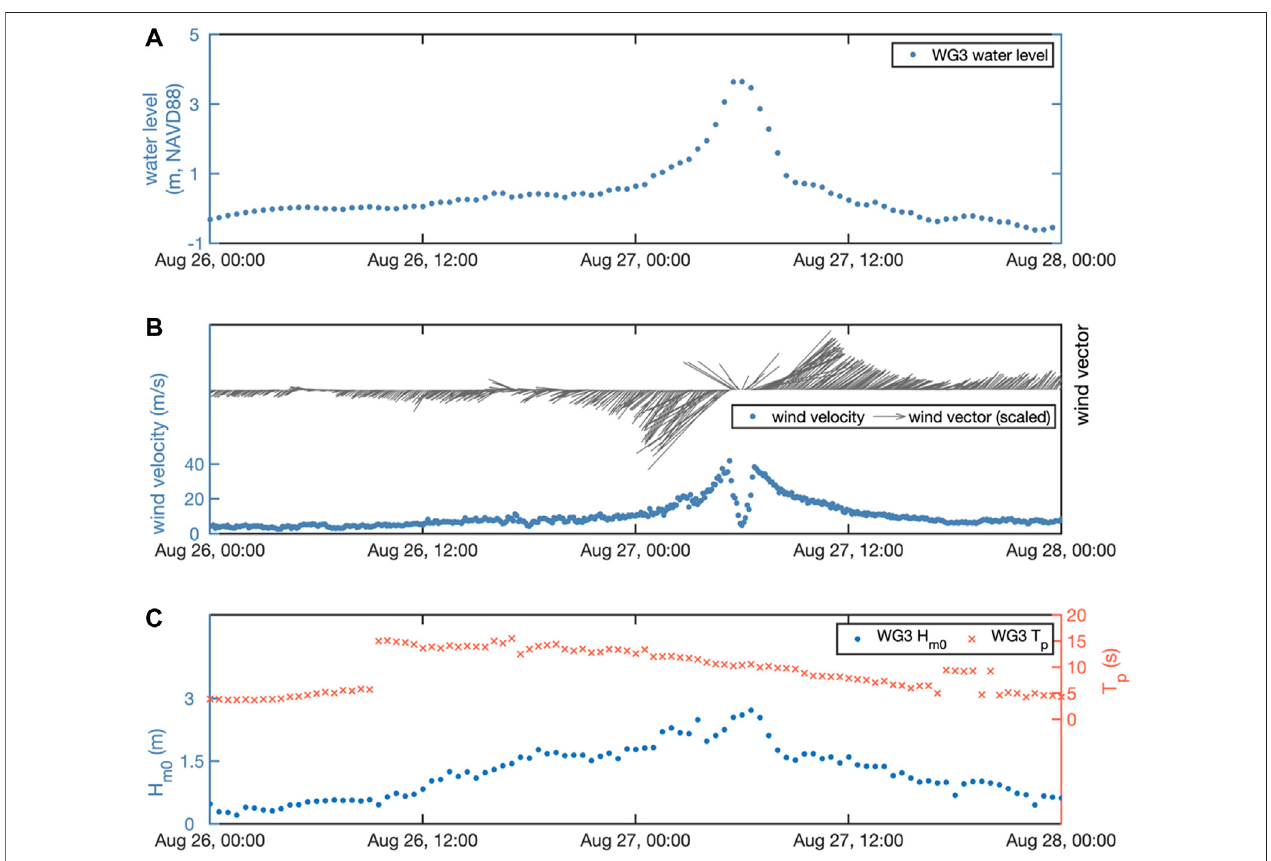
FIGURE 4| Time seriesof water level at theoffshore wave gauge (A) , wind speed and direction at NOAAstation 8768094 (B) , and zero-momentwaveheight H m 0 and peak wave period T p at the offshore wave gauge (C) .